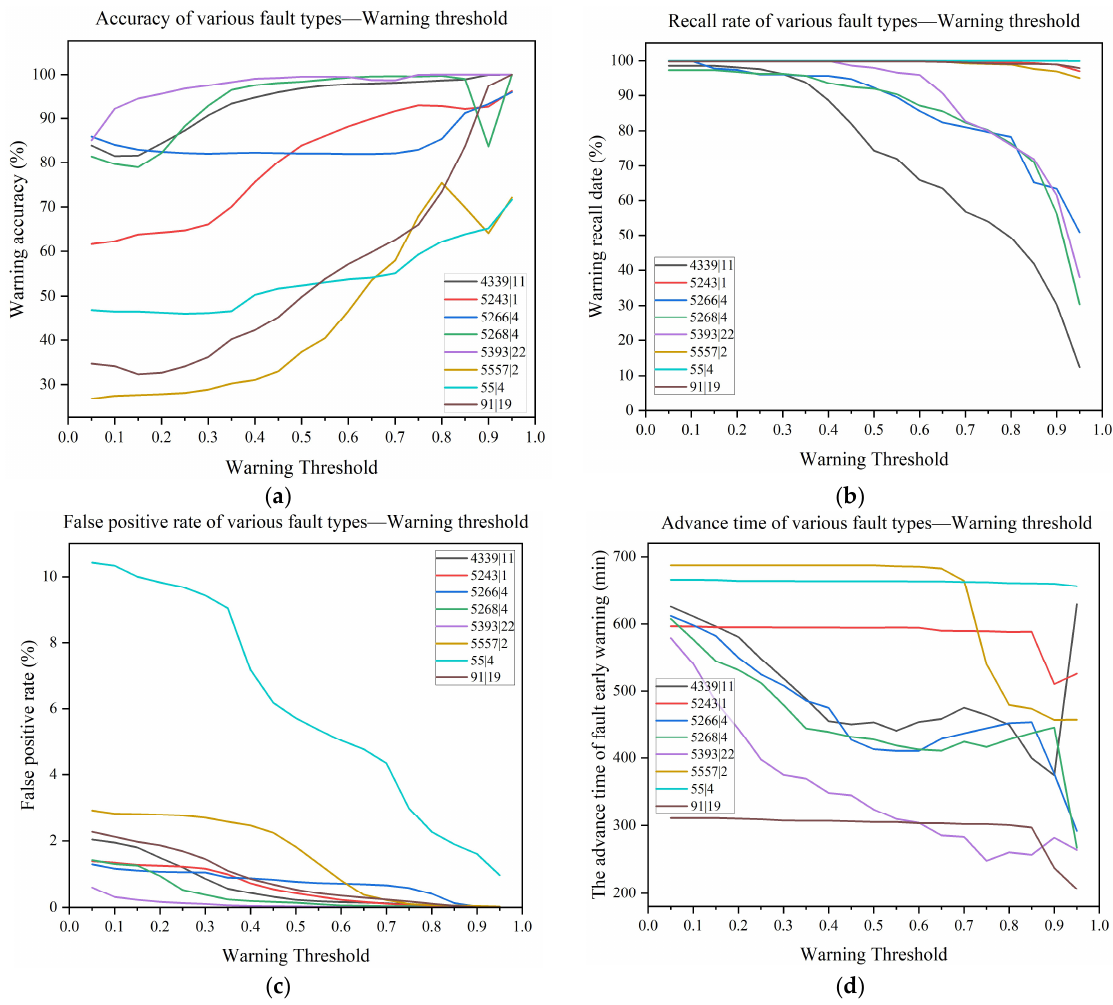
Figure 5. Evaluation metrics of various faults—Early warning threshold. ( a ) Accuracy of various fault types—Warning threshold ; ( b ) Recall rate of various fault types—Warning threshold; ( c ) False positive rate of various fault types—Warning threshold; ( d ) Advance time of various fault types—Warning threshold.